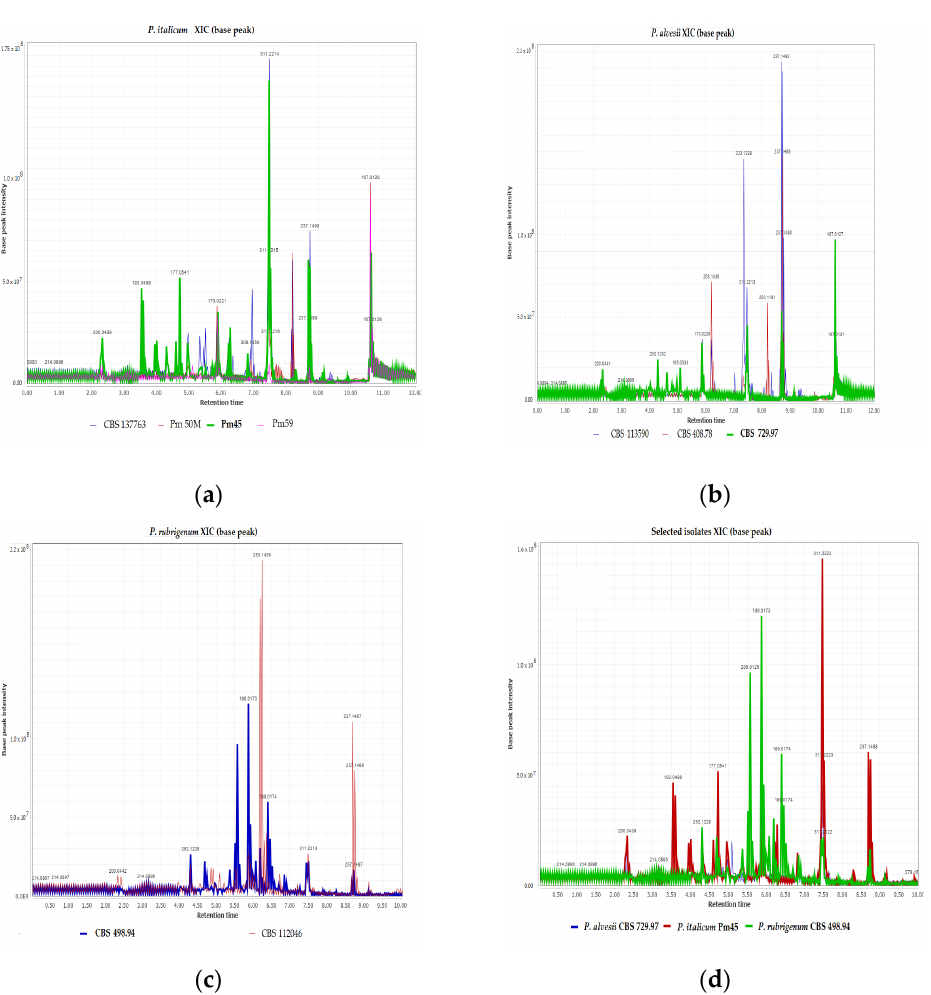
Figure 4. ( a ) Phaeoacremonium italicum isolates TICs comparison; ( b ) P. alvesii isolates TICs com- parison; ( c ) P. rubrigenum isolates TICs comparison; ( d ) Phaeoacremonium species and isolates selected for further investigation.